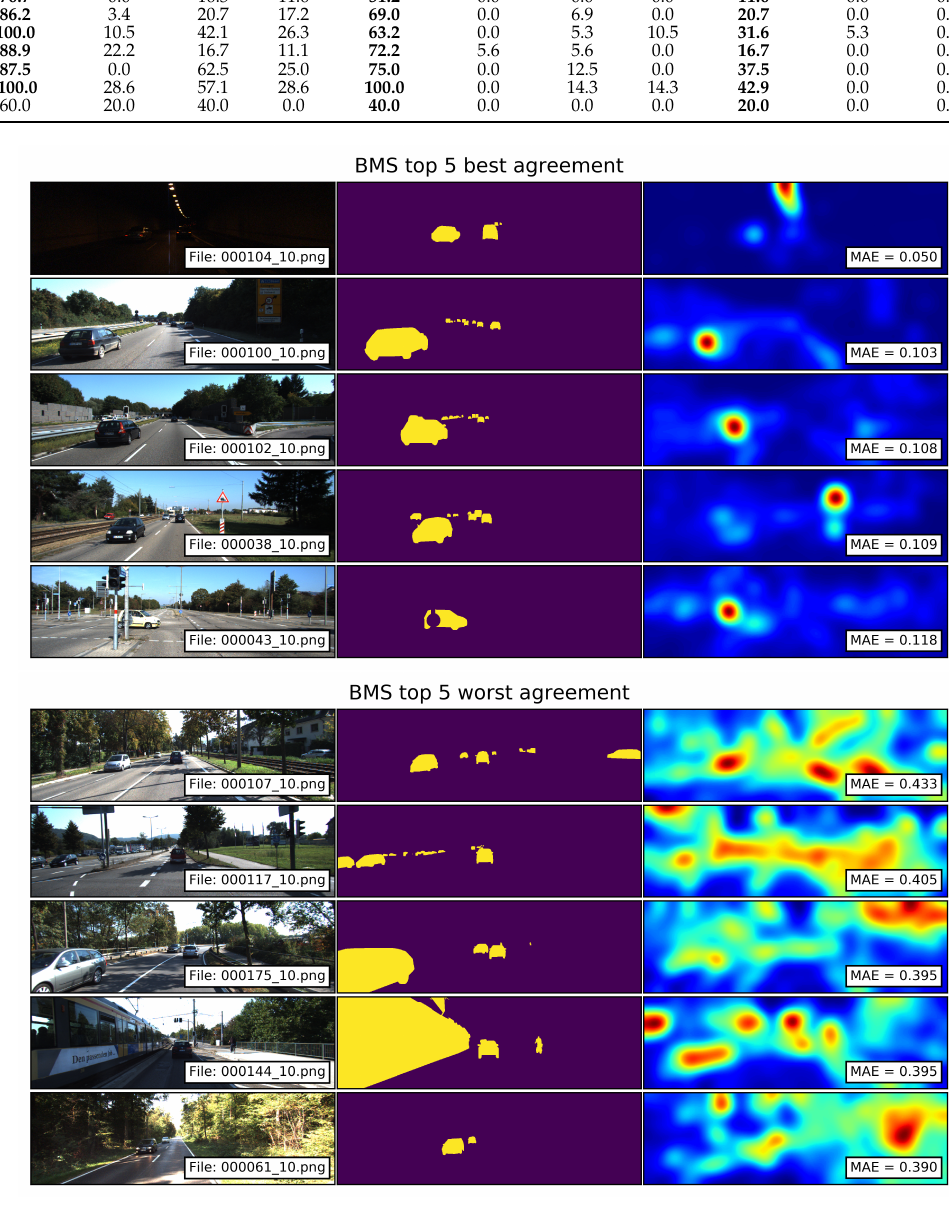
Figure 8. Top 5 best and worst agreements between the segments of traffic participants and the saliency maps computed with the BMS model. Smaller MAE values correspond to a better agreement. The saliency maps with the worst agreements show that even though smaller traffic par- ticipants in the background fall within salient areas, elements in the background such as